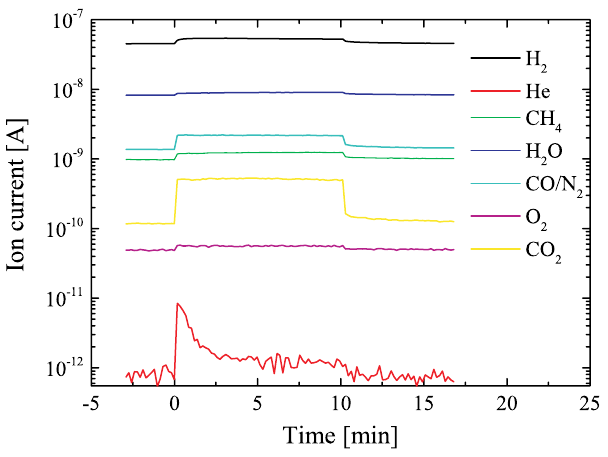
FIG. 7. Partial pressure rise during the final laser